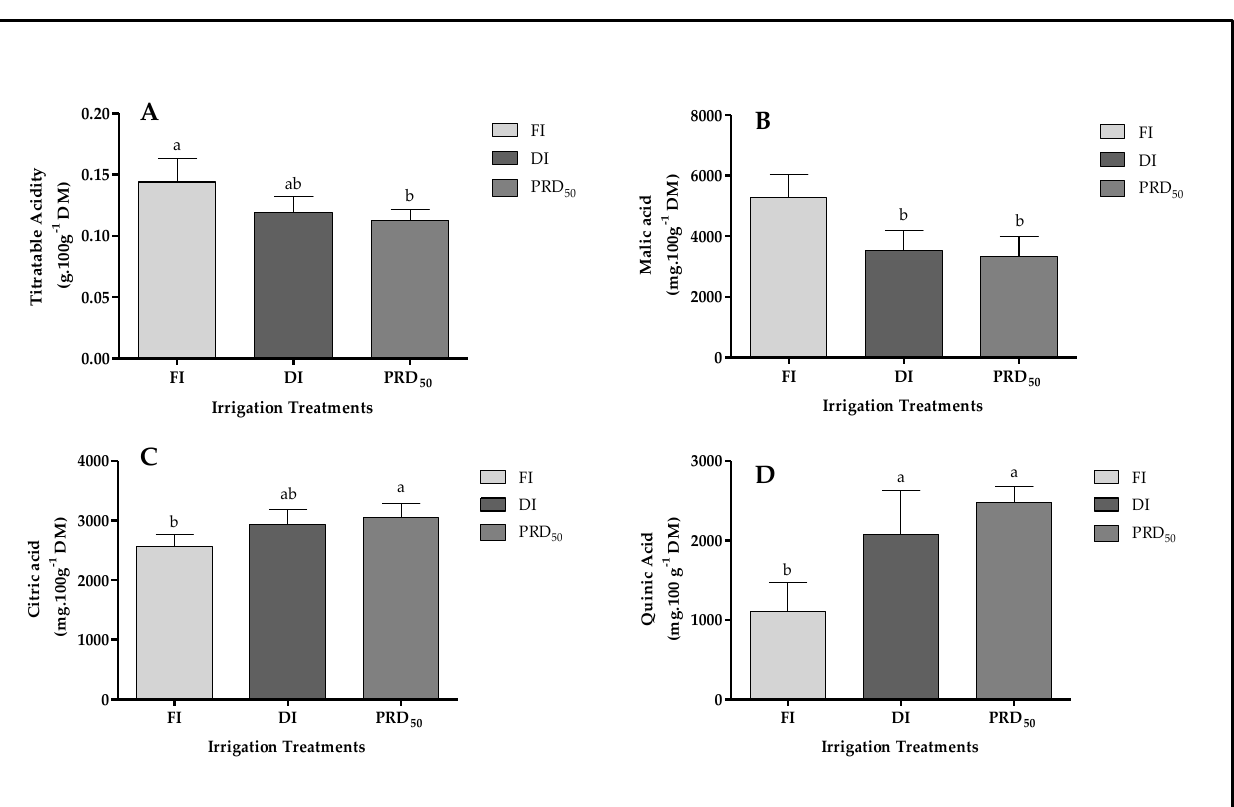
Figure 6. Titratable acidity ( A ) and organic acid content (malic acid ( B ), citric acid ( C ) and quinic acid ( D )) in Flordastar peaches grown under FI, DI and PRD 50 irrigation treatments, expressed in mg 100 g − 1 DM. Data are mean values ± SD. Different letters refer to significant differences tested by Duncan’s multiple range test ( p ≤ 0.05).